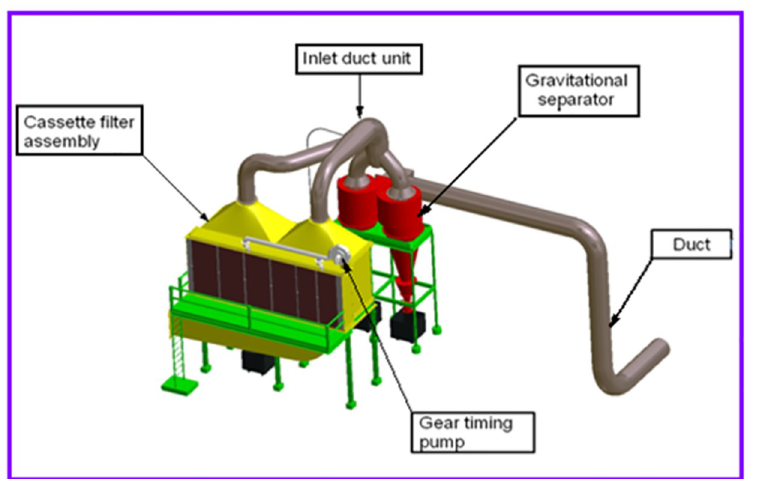
Fig 3. The detailed view of the cartridge